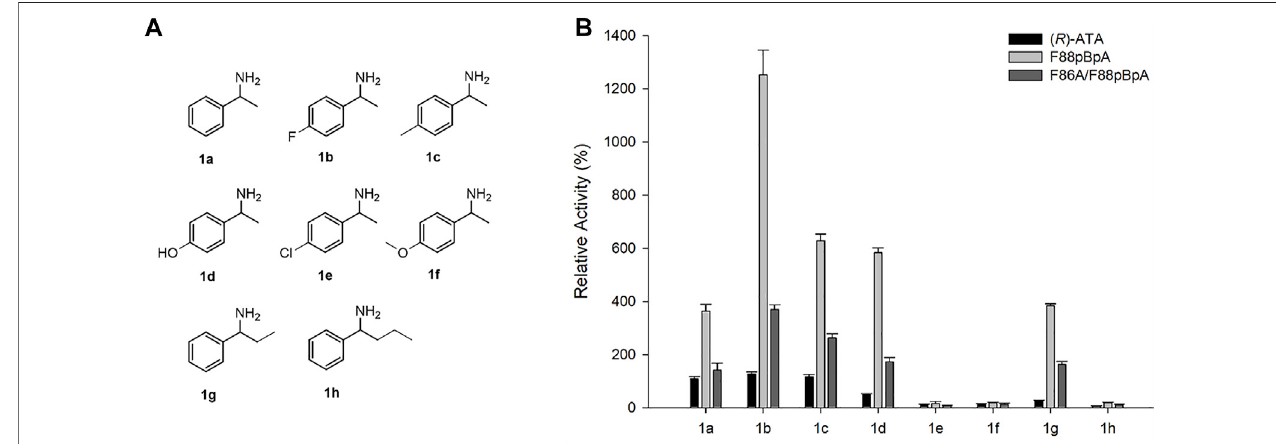
FIGURE 4 | Amino donor speci fi city of selected ( R )-ATA mutants (A) Substrate structures and (B) Relative activity. Different concentrations of the enzyme were used to determine speci fi c activity exactly. Speci fi c activity of ( R )-ATA for 1a (324 mU mg − 1 ) was taken as 100%.